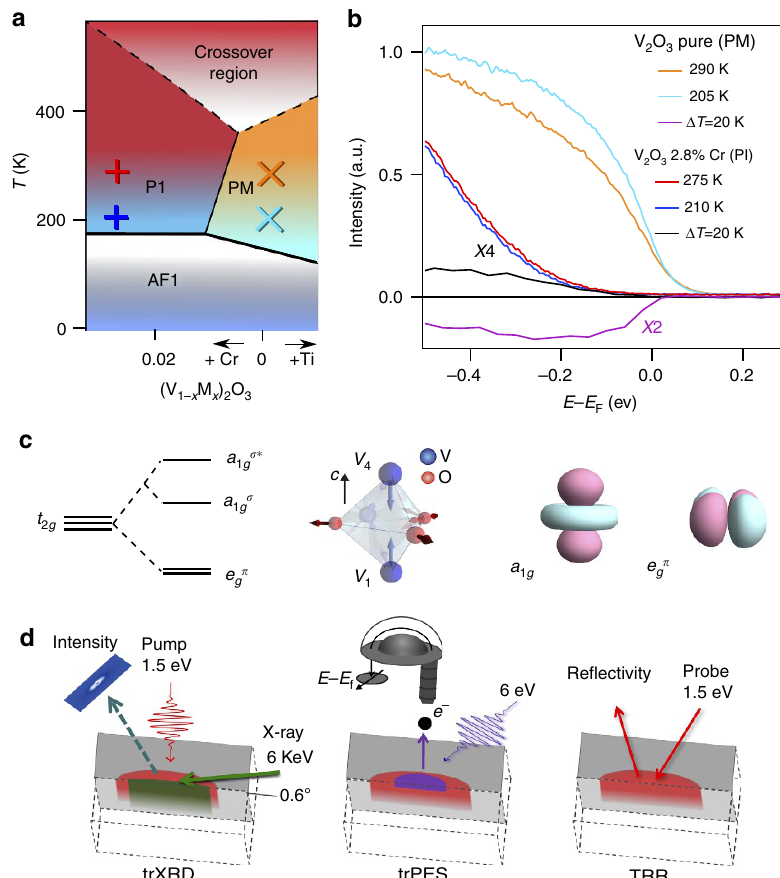
Figure 1 | Equilibrium properties of (V 1 (cid:2) x M x ) 2 O 3 and experimental techniques used. ( a ) (V 1 (cid:2) x M x ) 2 O 3 phase diagram; the cross and the plus symbols indicate the experimental data points. ( b ) Temperature dependence of the equilibrium photoemission spectra for (V 1 (cid:2) x Cr x ) 2 O 3 ( x ¼ 0.028 PI phase, x ¼ 0PM phase). Temperature differences are shown for each doping, which are used as a thermal equilibrium reference in comparison with the photoexcited spectra. Upon increasing the temperature, the spectral weight is transferred into the Mott gap in the PI phase, whereas the QP peak weakens in the PM phase. ( c ) Representation of the orbital splitting and their geometry. ( d ) Schematic of the experiments using an optical pump and different probes: trXRD, trPES and